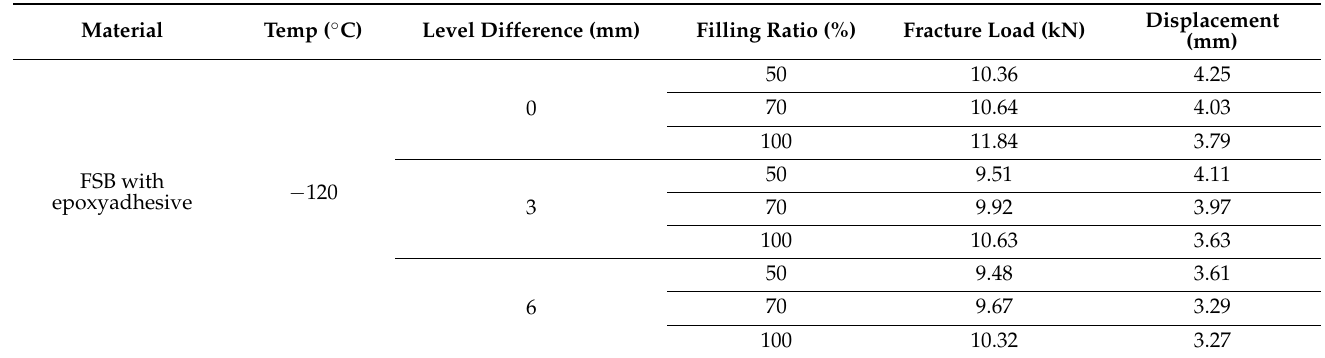
Table 2. Mechanical properties of the FSB under each